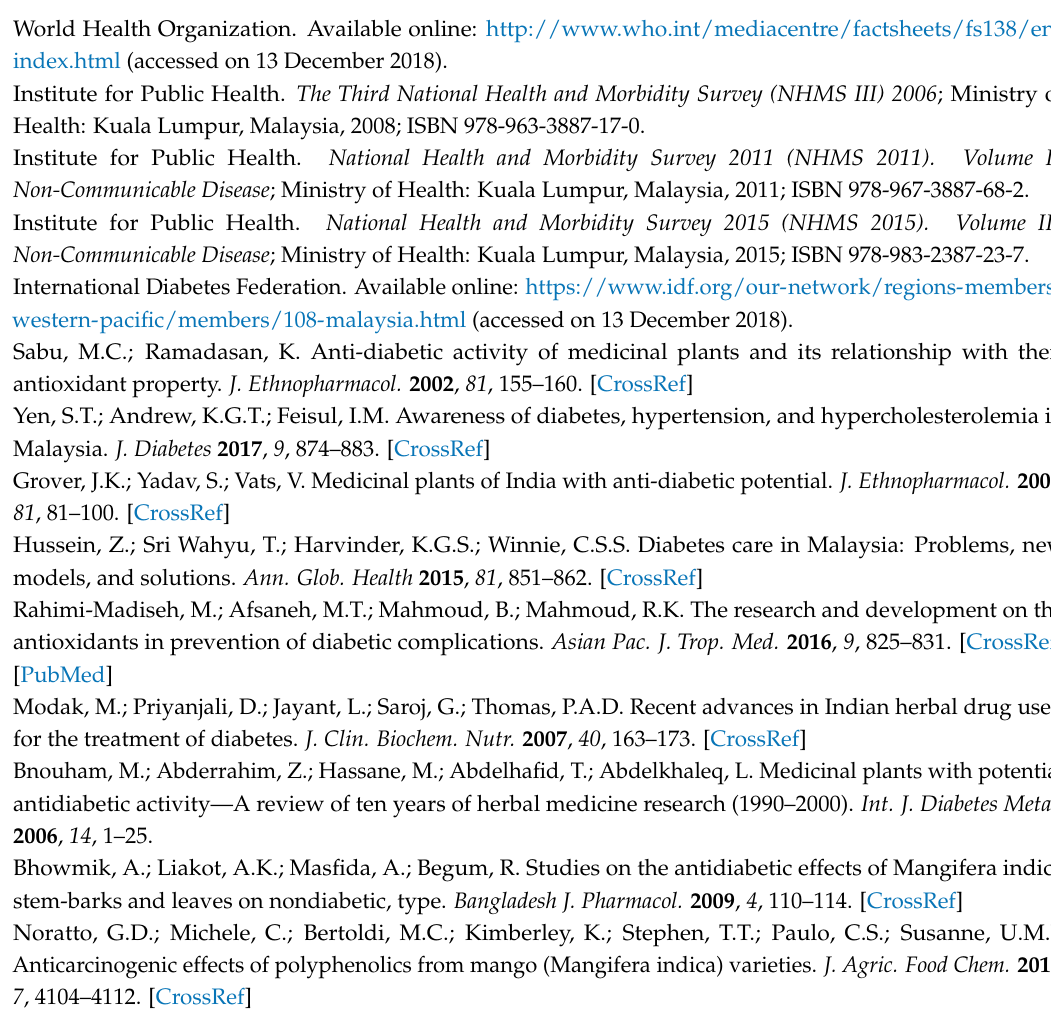
Supplementary Materials: The following are available online, Figure S1: Standard chromatogram of polyphenols by LC-MS/MS, Figure S2: Sample (Peel (A) and Seed kernel (B)) chromatogram of single polyphenol detected by LC-MS/MS., Figure S3: Molecular structure of compounds in the peel and seed kernel extract of M. odorata that were detected during screening using LC-MS (on the left), and identified using LC-ESI-Q-TOF-MS (on the